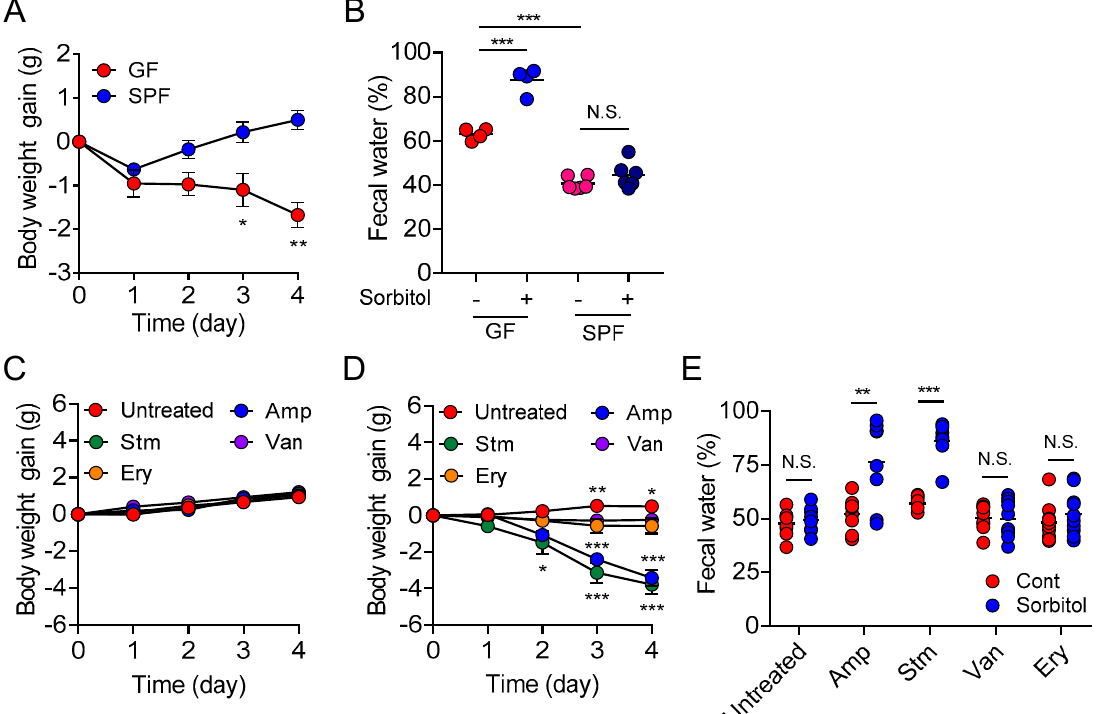
Figure 1. Specific Gut Microbiota Contributes to the Suppression of Sorbitol-Induced Diarrhea. ( A , B ) SPF and germ-free (GF) ICR mice were provided drinking water containing 5% sorbitol for 4 days. ( A ) Body weight changes from day 0 to